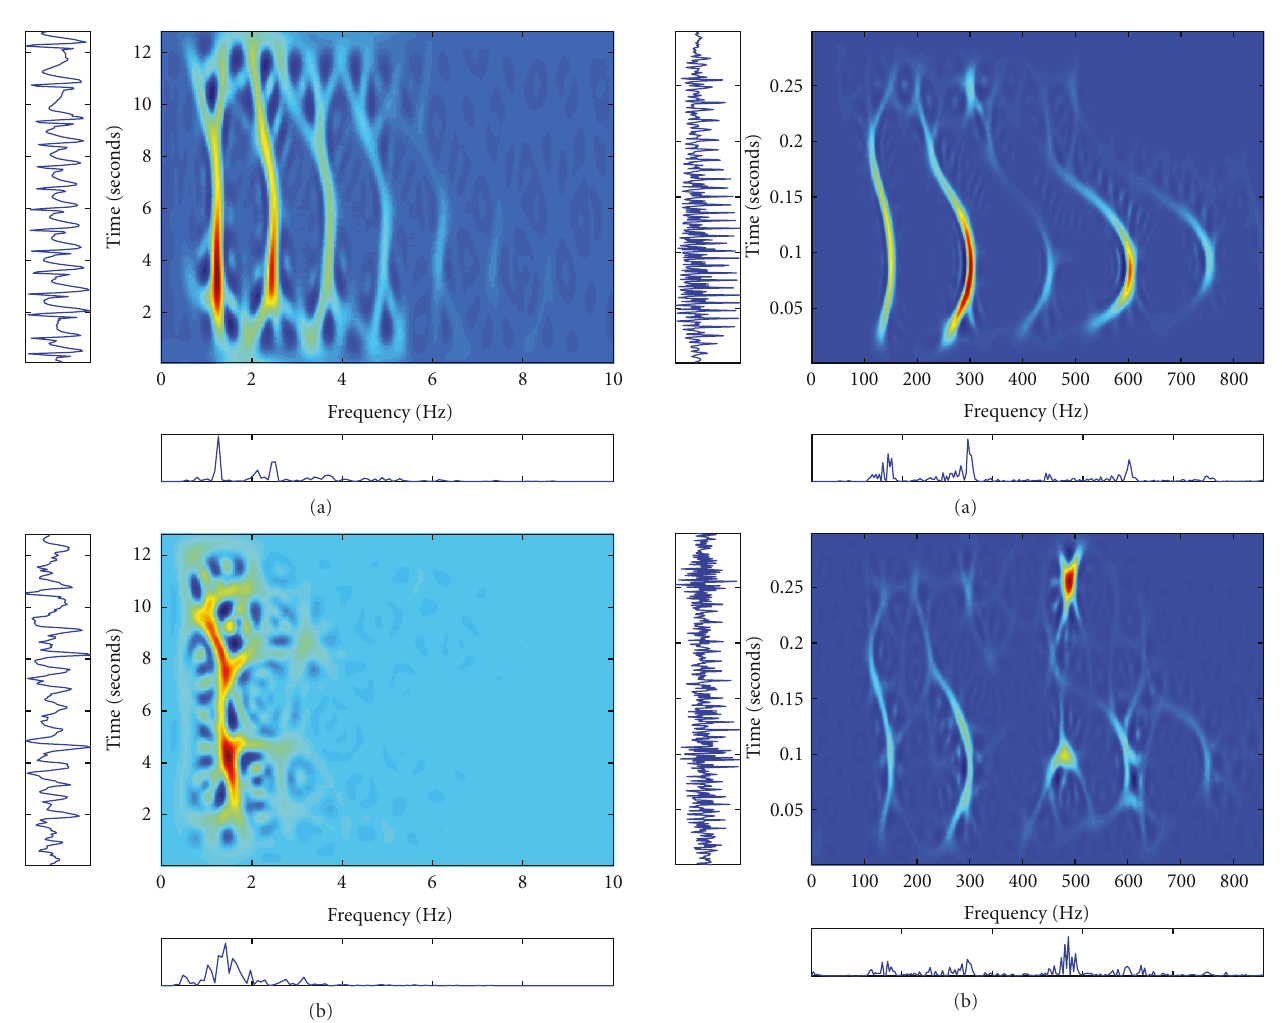
Figure 9: Epoch of newborn EEG with seizure (a) and nonseizure (b) activity.